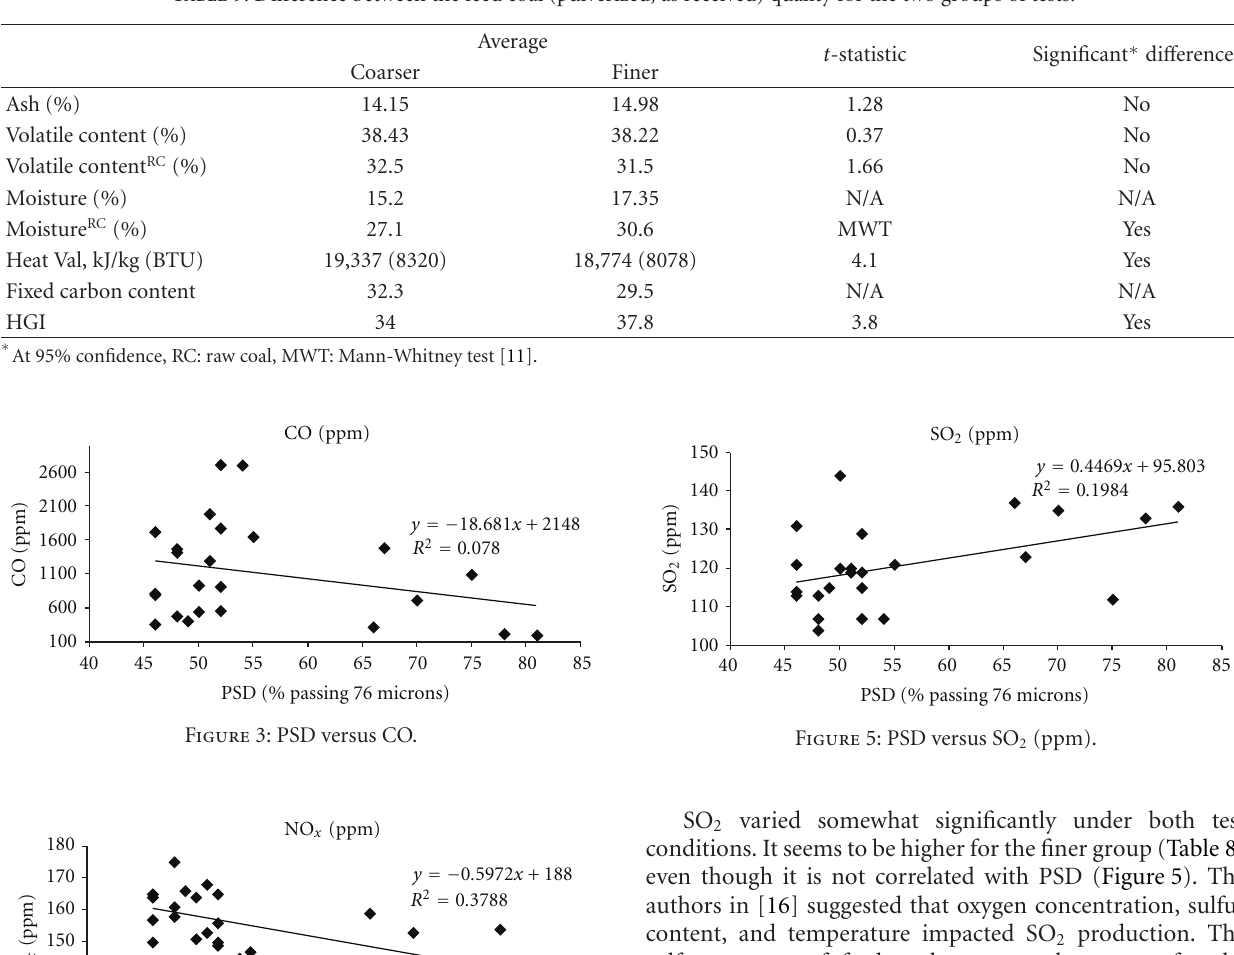
Table 9: Di ff erence between the feed coal (pulverized, as received) quality for the two groups of tests.